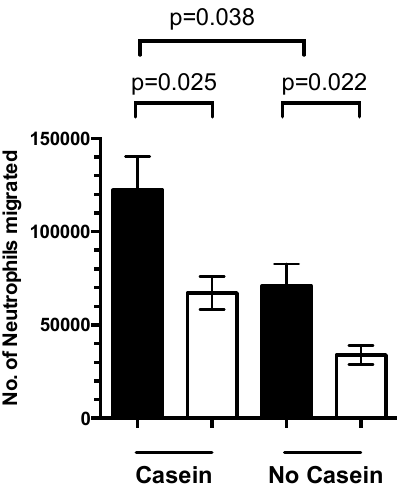
Figure 6. Effects of 1,25(OH) 2 D 3 pre ‐ treatment on neutrophil migration. A total of 4 × 10 6 neutrophils were pre ‐ treated with 100 nmol/L of 1,25(OH) 2 D 3 for 1 h followed by 1 h stimulation with 5.2 mg/mL casein. Bars represent mean ± SEM ( n = 7). Significance was calculated using a Student’s t ‐ test (black bar = untreated; white bar = 1,25(OH) 2 D 3 ).